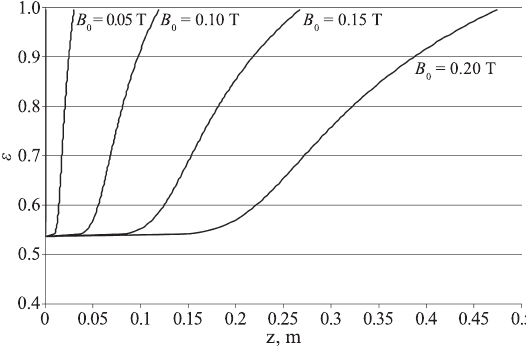
Fig. 3 Profiles of void fraction in the proximity of the free - board region as computed by Eqn. 30 at different mag - netic field